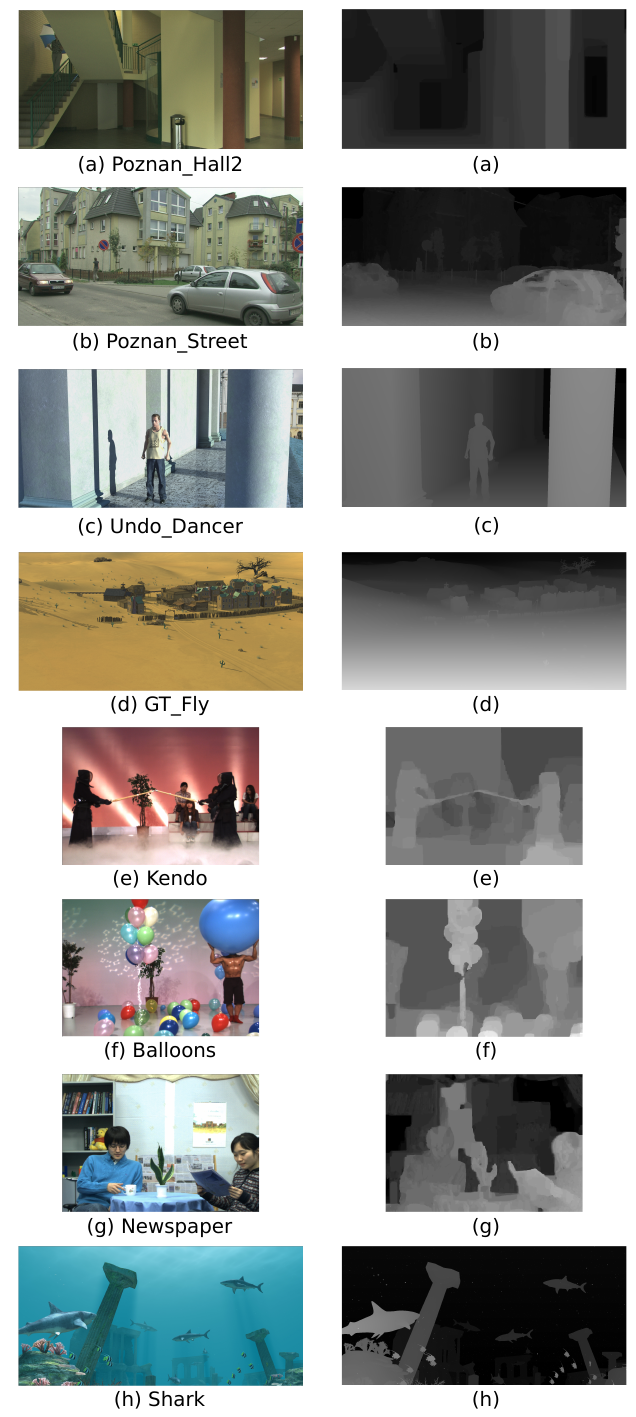
Figure 5. Test images; ( a – d , h ): 1920 × 1088, ( e – g ): 1024 ×